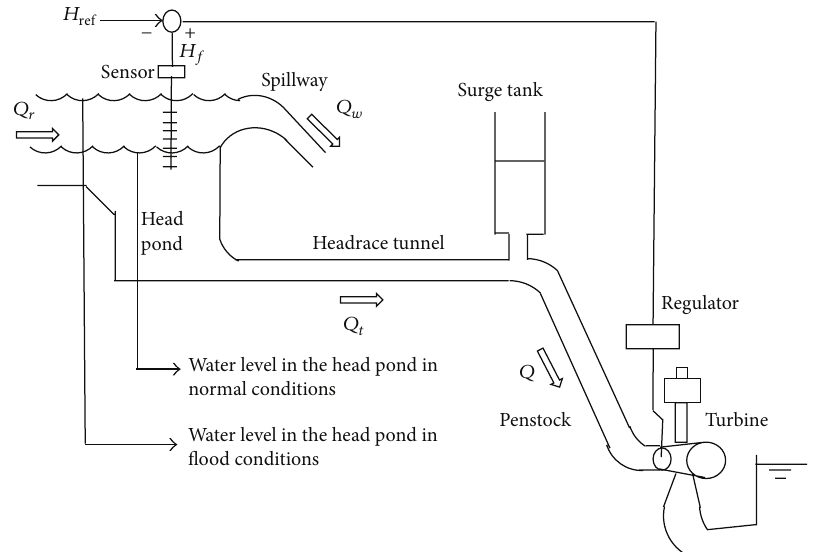
Figure 1: Run-of-river diversion hydropower plant with surge tank and spillway in the head pond.